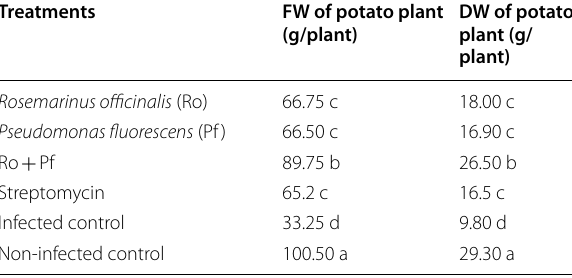
Values in the column followed by different letters indicate significant differences among treatments according to a least significant differences test ( P